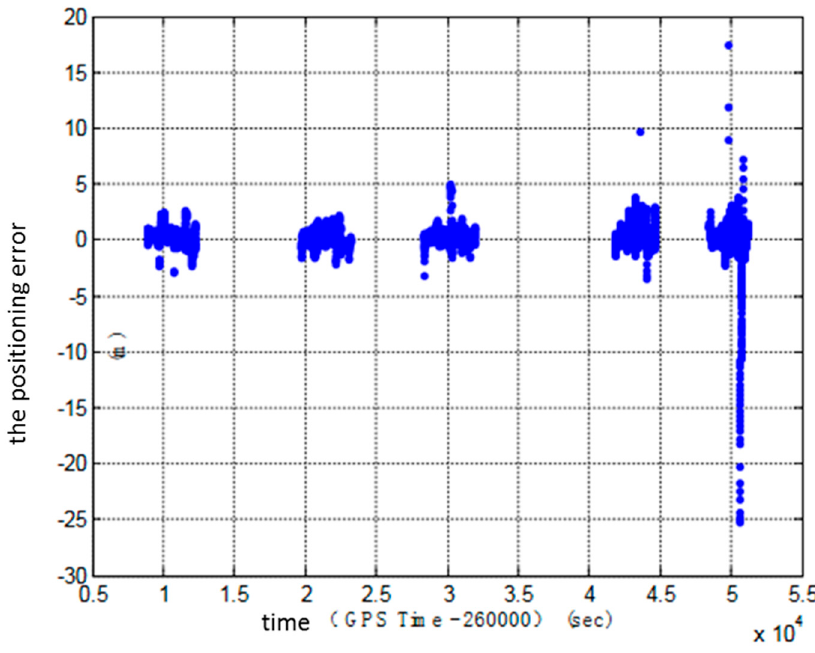
Figure 5. The location error (fixed solution) in the lateral direction of the lane in five tests.